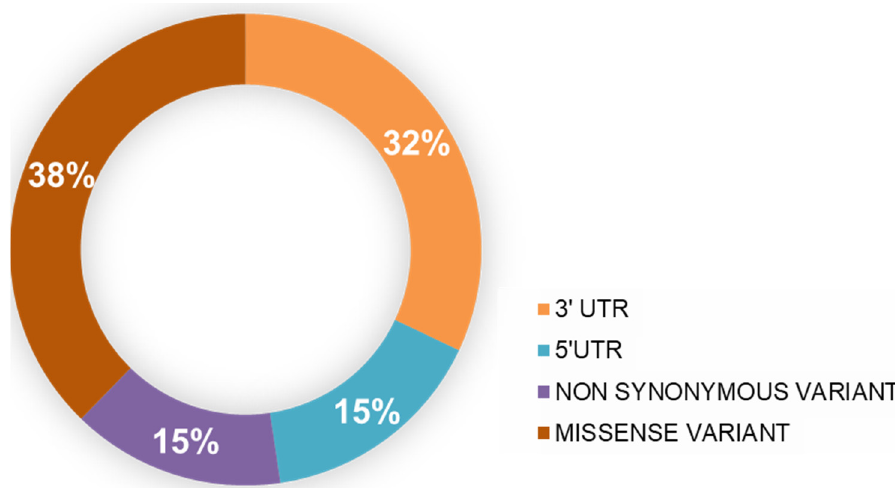
Figure 2. Representation of four different types of SNPs in PARK7 using the Ensembl genome browser.